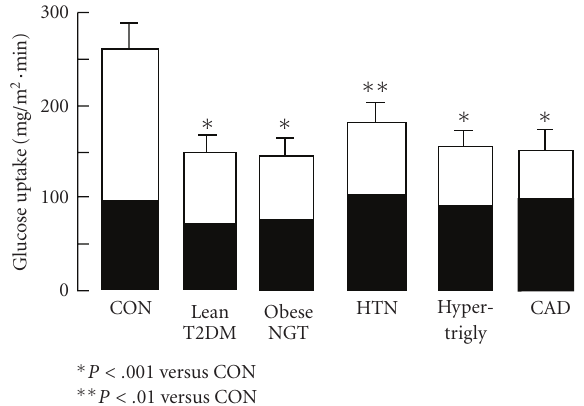
Figure 3: Insulin-stimulated glucose disposal (40mU/m 2 · min euglycemic insulin clamp) in lean healthy control (CON) sub- jects, lean drug na¨ıve type 2 diabetic subjects (T2DM), lean normal-glucose-tolerant (NGT) hypertensive subjects (HTN), NGT hypertriglyceridemic subjects, and nondiabetic subjects with coronary artery disease (CAD). The open portion of the bar represents nonoxidative glucose disposal (glycogen synthe- sis) and the solid portion represents glucose oxidation. See DeFronzo and Ferrannini [80], DeFronzo